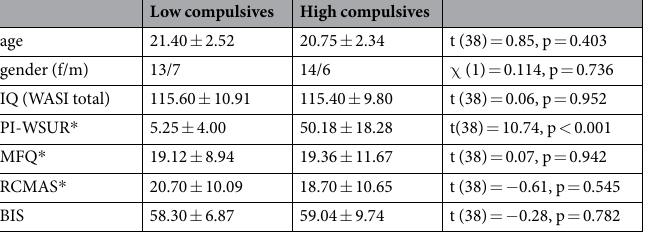
Table 1. Participants with high and low compulsivity scores. Two groups of participants were recruited from a population-based database, based on their compulsivity scores (PI-WSUR). The groups were matched for other psychiatric dimensions, especially depression (MFQ) and anxiety (RCMAS). Groups did not differ in age, gender, IQ, or impulsivity (BIS). (mean ± SD). * Data used for